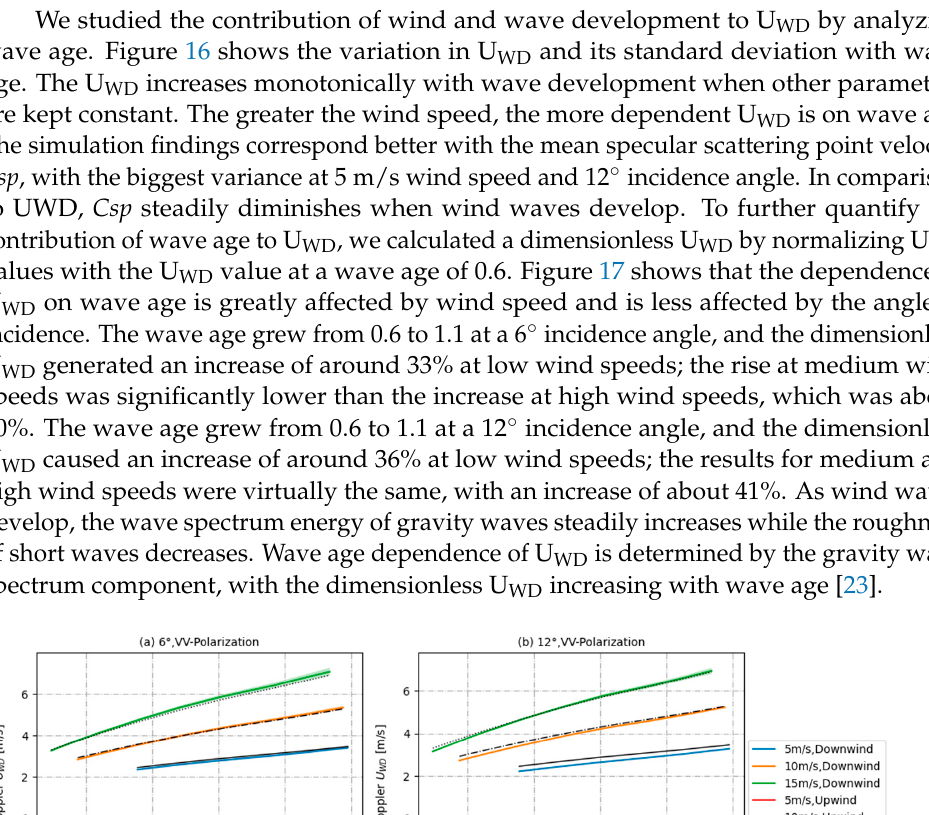
Figure 15. Relationship between wave age and wind fetch in Elfouhaily spectrum.